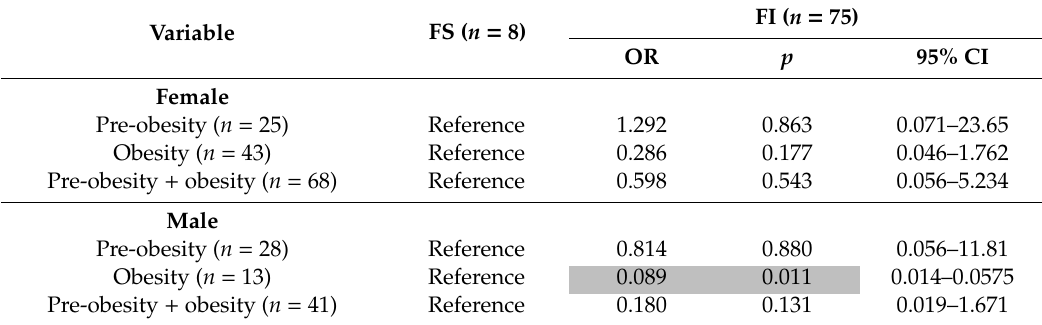
Table 4. Odds Ratios and 95% CI between each obesity group and food insecurity level among male and female migrant farm workers in Northwest Mexico.